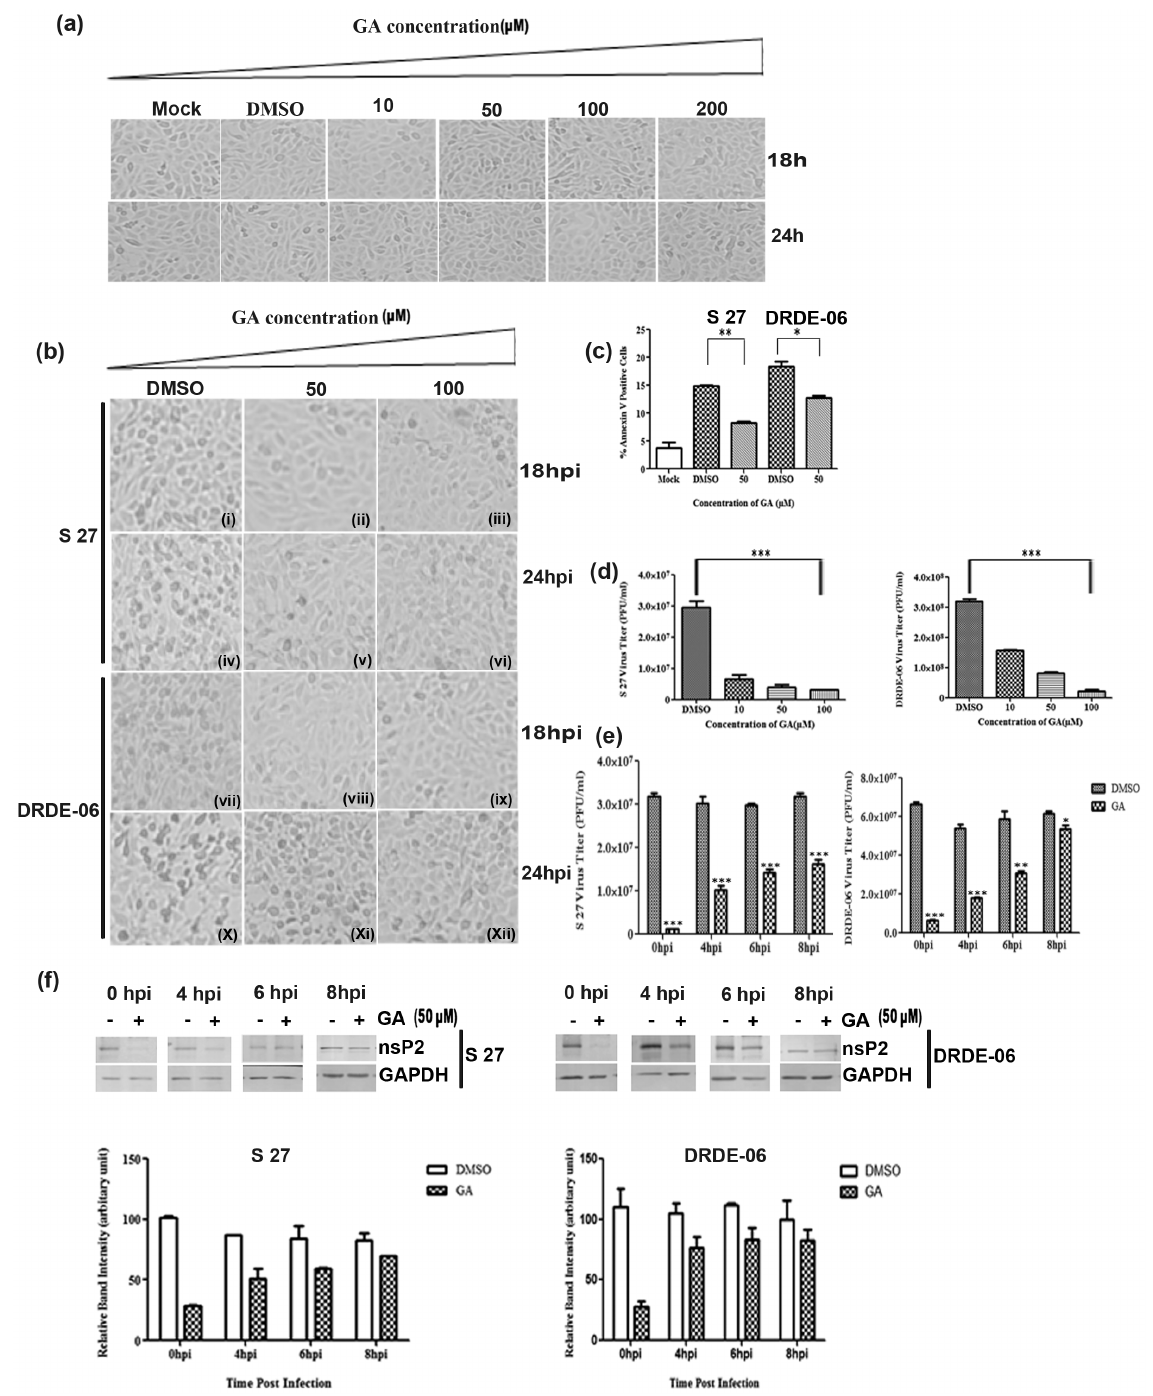
Figure 2. Hsp90 inhibitor GA inhibits CHIKV replication. (a) Vero cells were infected with CHIKV strains, either S 27 or DRDE-06 with MOI 0.01. Effect of GA (10, 50, 100, 200 m M) on (a) uninfected cells (b) in the progression of infection was determined by observing the CPE of the virus infected cells under microscope (Magnification -10X) at 18 and 24 hpi. (c) The mock and CHIKV (S 27 or DRDE-06) infected Vero cells in presence or absence of GA (50 m M) were analyzed for apoptosis by staining with Annexin V and estimating % positive cells for Annexin V. The graph depicts a representative experiment with triplicate values of mean 6 SD (* p , 0.05). (d) The supernatants of the virus infected and GA treated cells were collected at 14 hpi and viral titers were determined by plaque assay. The data represent the mean 6 SD of three experiments (* p , 0.01). (e) GA was added to the virus infected cells at 0, 4, 6, 8 hpi and supernatants were collected at 14 hpi and infectious progeny virus particle titre was determined by plaque assay. All the experiments were repeated three times and data of three independent experiments are represented as mean 6 SD (* p , 0.05). (f) The infected cells (as mentioned in 2e) were harvested and nsP2 protein level was determined by Western blot by probing with nsP2 monoclonal antibody. GAPDH served as the loading control. The fold change in the nsP2 protein level was quantified by normalizing GAPDH and the relative band intensity is shown as bar diagram in the lower panel (n=3, p , 0.01).